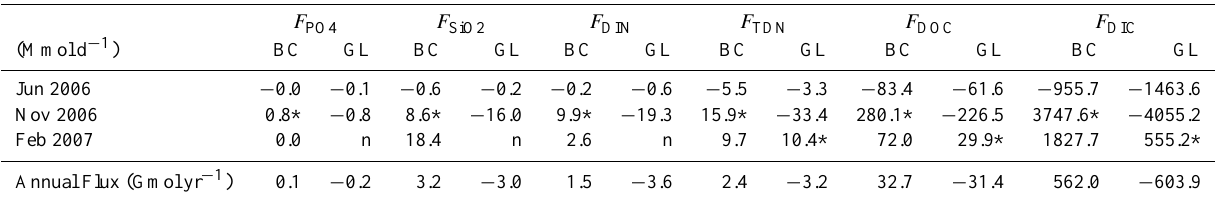
Table 2. Fluxes of phosphate ( F PO4 ) , silicate ( F SiO2 ) , dissolved inorganic nitrogen ( F DIN ) , total dissolved nitrogen ( F TDN ) , dissolved organic carbon ( F DOC ) and dissolved inorganic carbon ( F DIC ) during the three sampling periods in the two different transects (Bay of C´adiz (BC) and Guadalquivir estuary (GL)). Extrapolate annual fluxes for every component. * means that the tidal cycle was not closed and the transport could be over-/underestimated. F